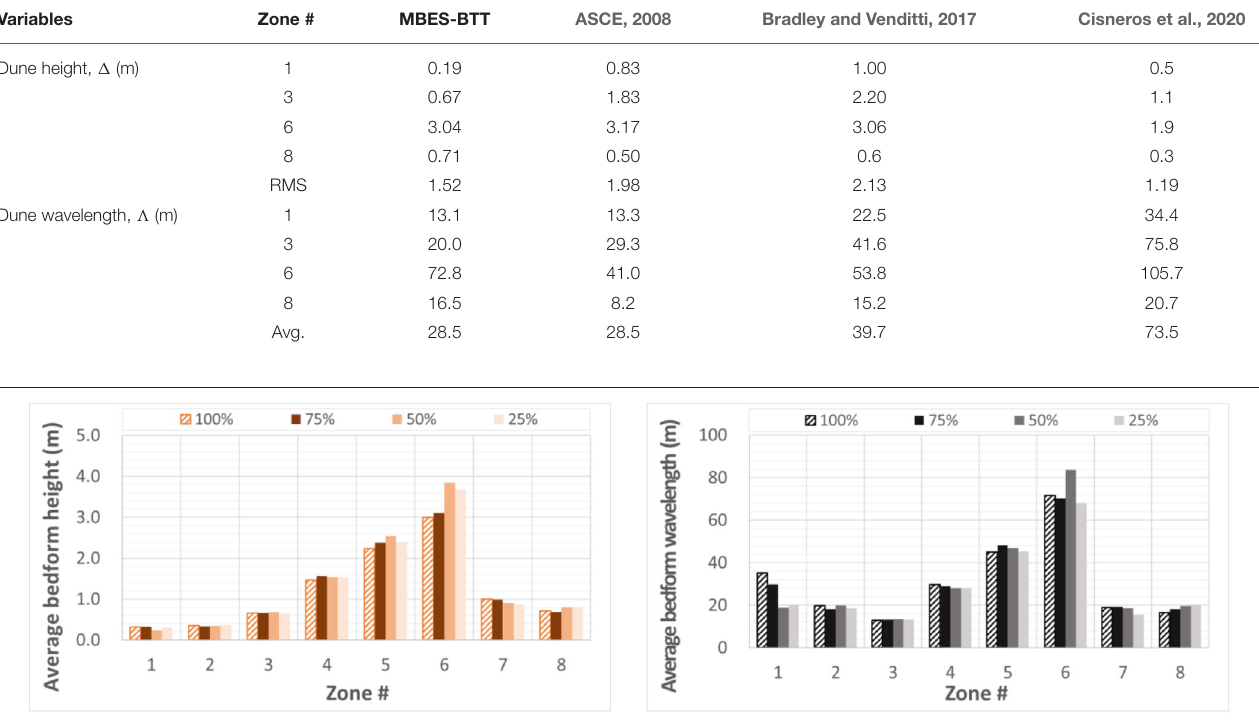
FIGURE 4 | Sensitivity of the bedform characteristics to the longitudinal dimension of the acoustic map: (A) average bedform height; (B) average bedform